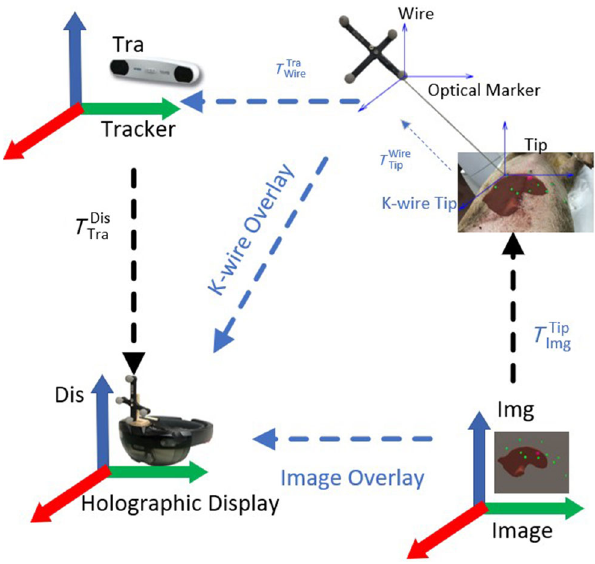
Fig. 3 Registration of 3D virtual structure and real